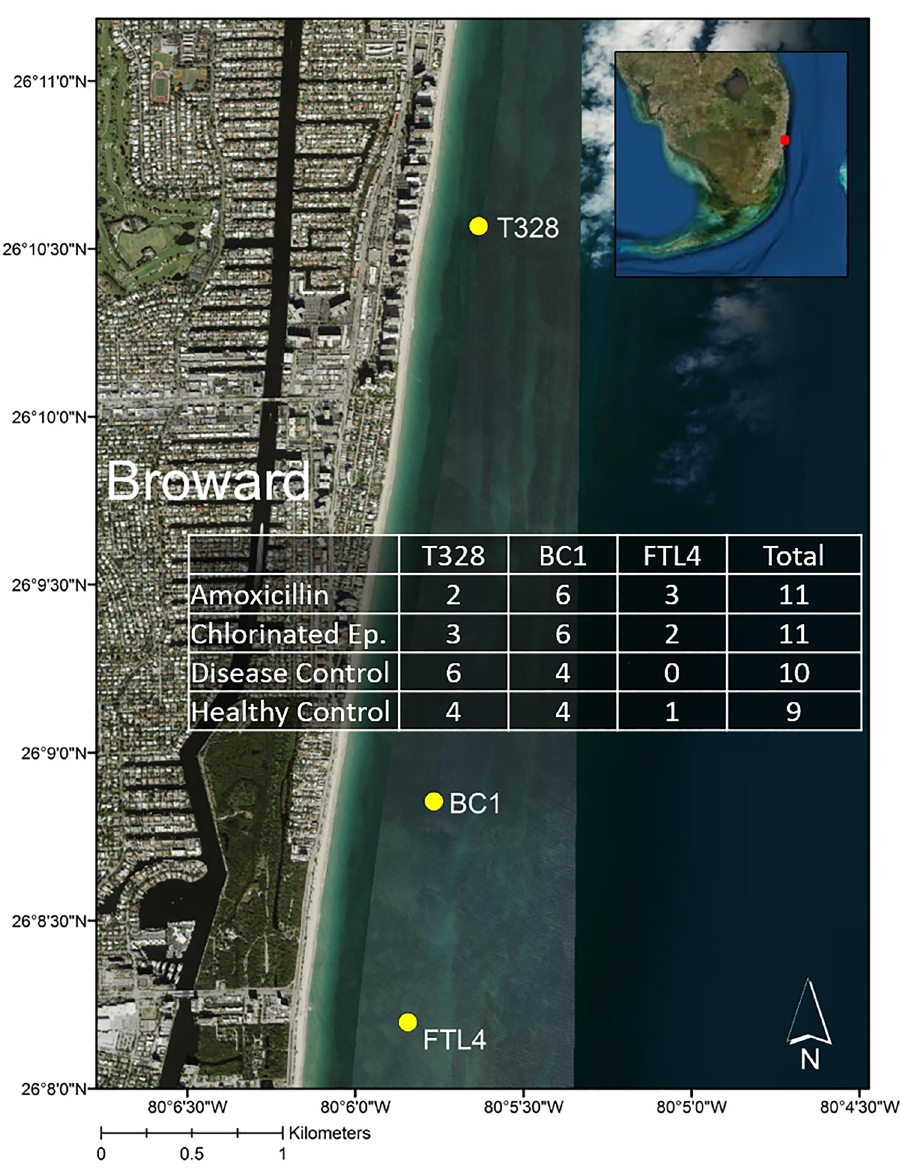
Figure 1. Satellite image of Broward County coast with sites utilized in this experiment denoted with yellow dots. The overlaid table lists sample sizes in each treatment group at each site, as well as treatment group totals across all sites. “Amoxicillin” refers to the Base 2B plus amoxicillin treatment, “Chlorinated Ep.” refers to the chlorinated epoxy treatment, “Disease Control” refers to the SCTLD-affected untreated colonies, and “Healthy Control” refers to healthy untreated controls. Map was created using ArcMap v10.1 software developed by ESRI (https ://www. esri.